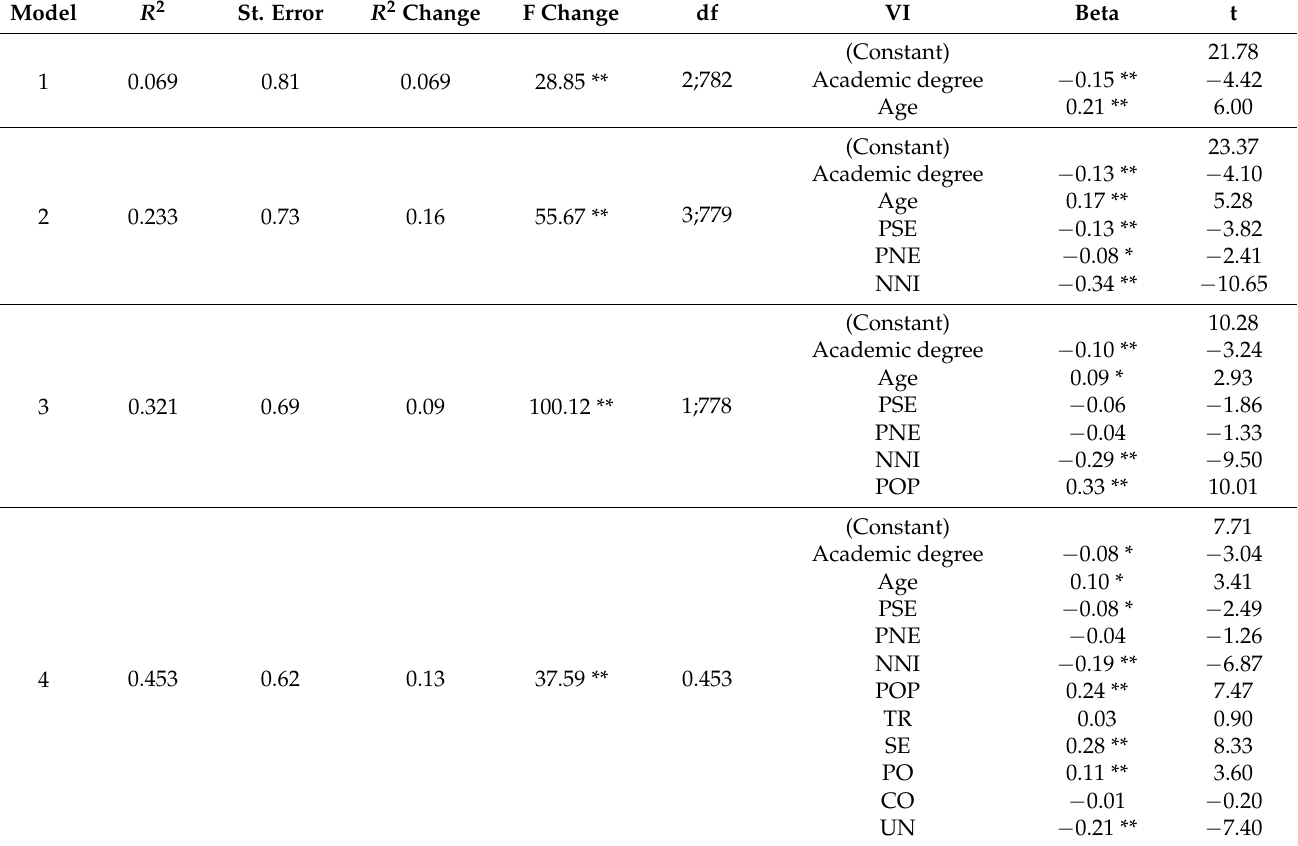
Table 3. Hierarchical linear regression. Support for exclusive